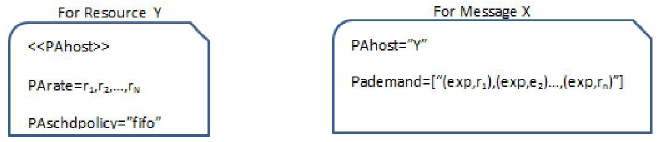
Fig. 2. The proposed stereotypes with